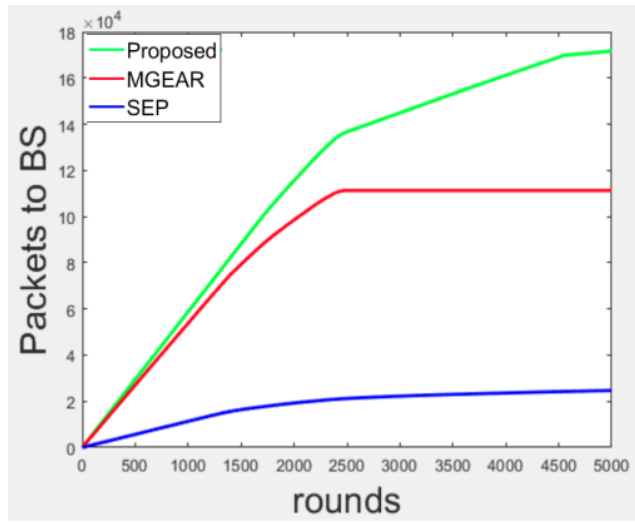
Figure 4. Packets sent to BS per